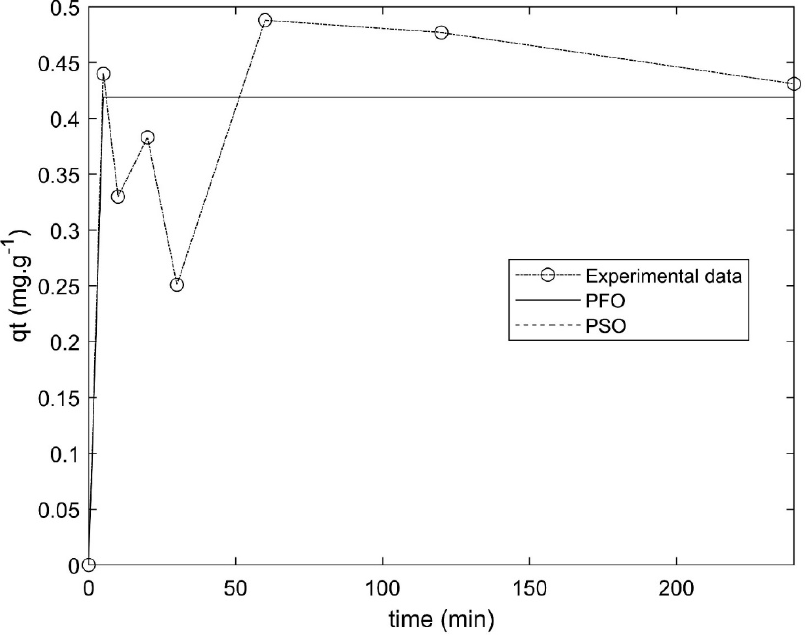
Table 5. Adsorption capacities of PO 4 by other biochar modified with Mg.